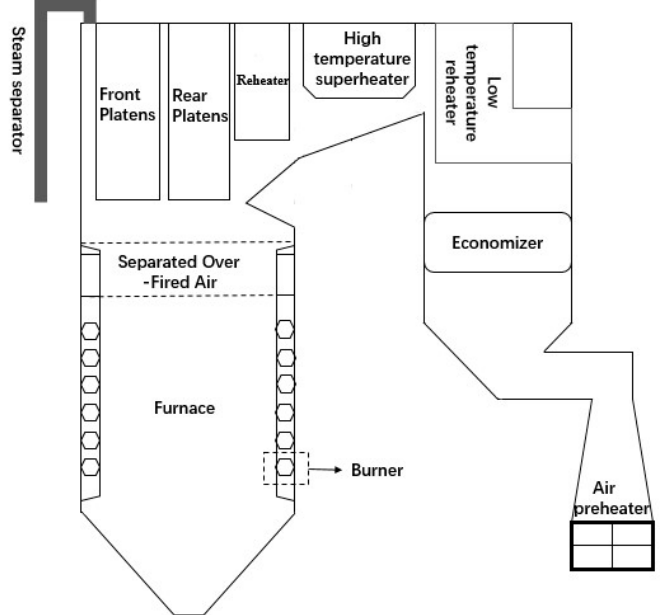
Figure 1. Schematic of the overall layout of the 600 MW supercritical boiler. Table 2. Designed thermal parameters of the boiler.